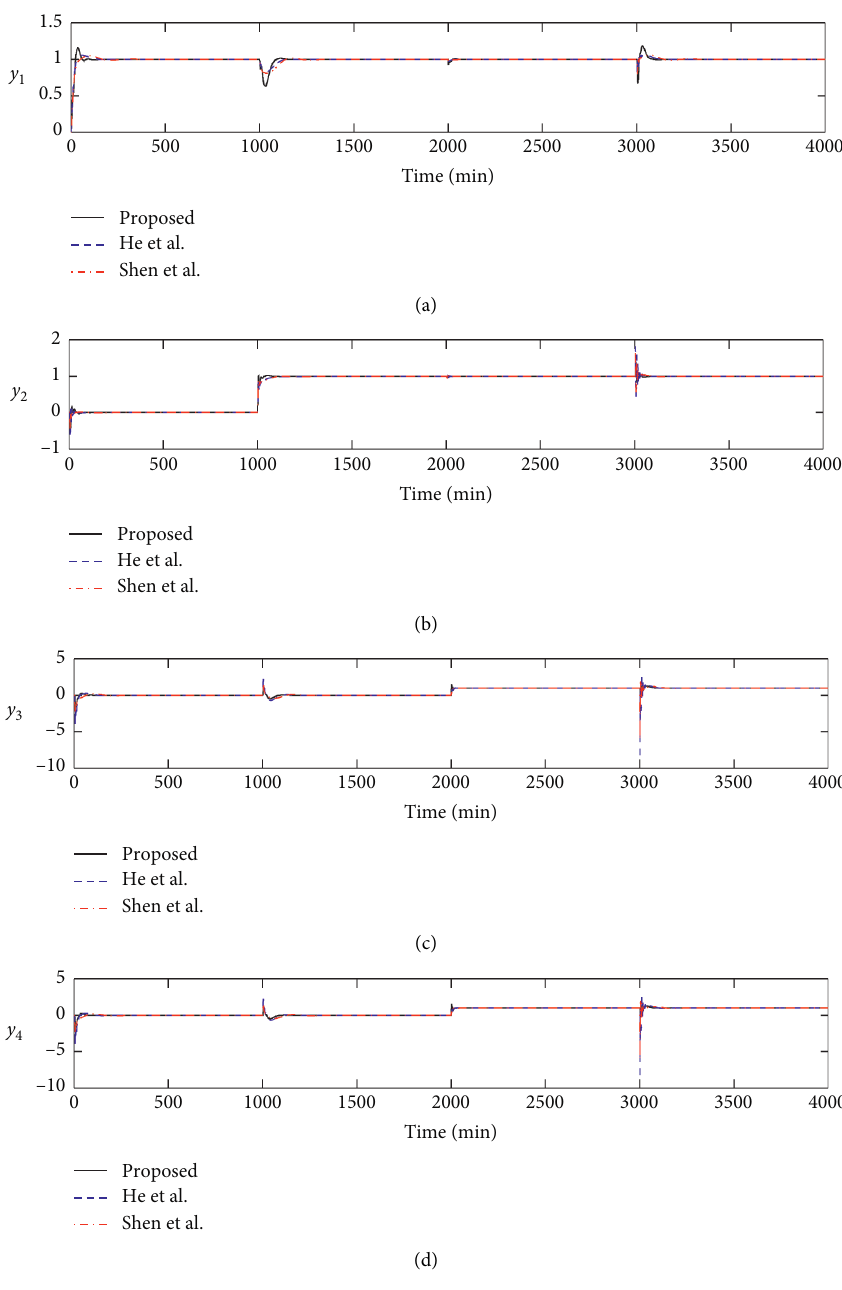
Figure 4: Closed-loop step responses for Example